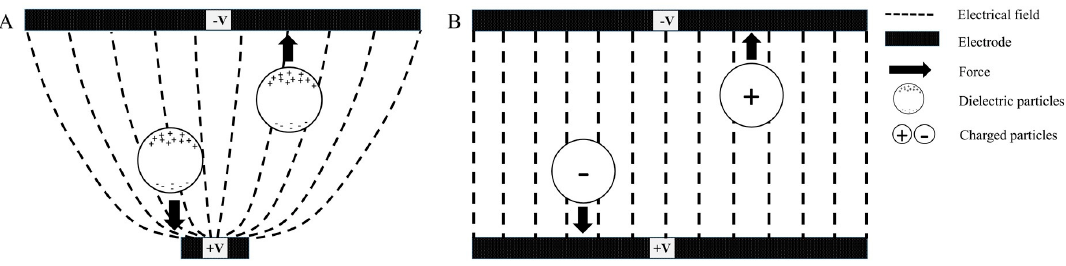
Figure 2. DEP spectrum (Re[ K ( ω )] vs. frequency) of a polarizable particle. ( A ) when σ p < σ m and ε p > ε m ; ( B ) when σ p > σ m and ε p < ε m .